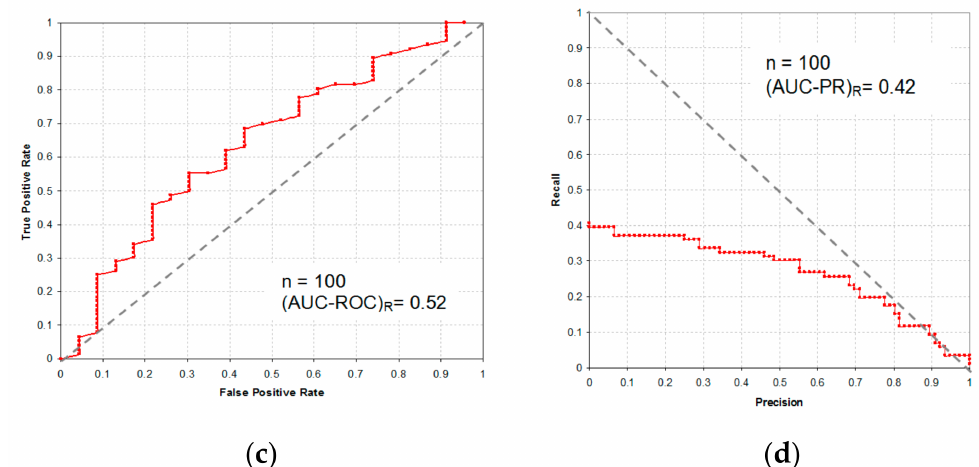
Figure 8. The differencies between comparing the models in ROC and PR space (sample size n = 100) for the ML-model in AUC-ROC space ( a ), ML-model in AUC-PR space ( b ), R-model in AUC-ROC space ( c ), and R-model in AUC-PR space ( d ).